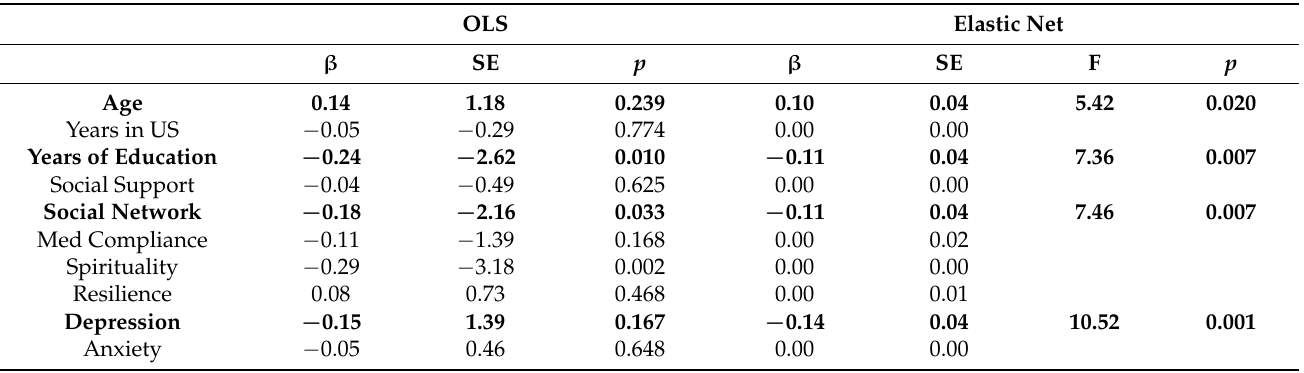
Table 4. Generalized Linear Regression Results of Predictors selected from the Elastic Net Regression: OLS and EN Predicting average METs per